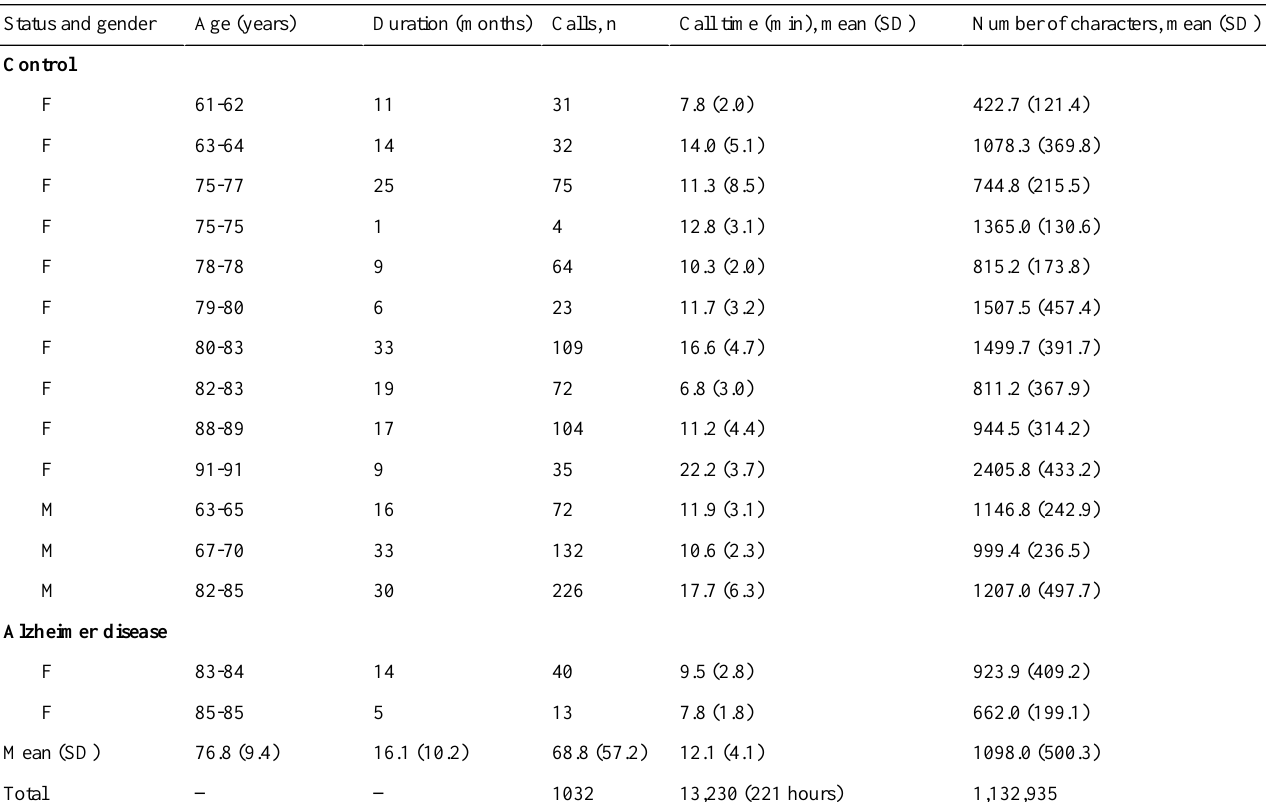
Table 1. Demographics of conversational data